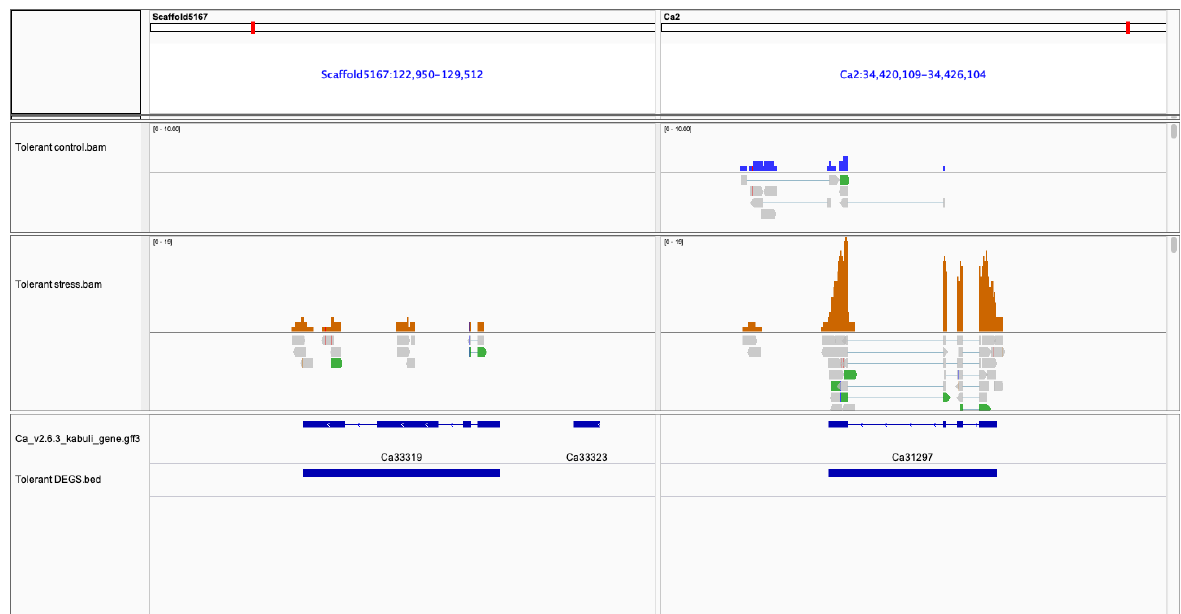
Figure 10. Integrative Genome Viewer (IGV) shows upregulation of jasmonic acid gene (Ca33319) induces FLC gene (Ca31297) in tolerant genotype in response to salt stress. The tracks include CDC frontier Kabuli v2.6.3 reference fasta; annotated gene. gff3; accepted.hits.bam from tolerant control and tolerant stress and differentially expressed gene coordinates.